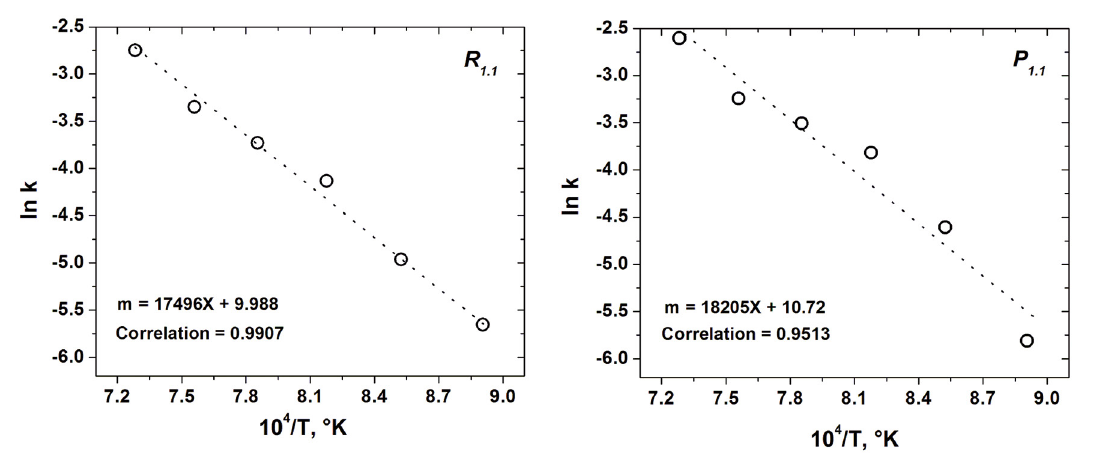
Al O SO strontium 4 6 12 4